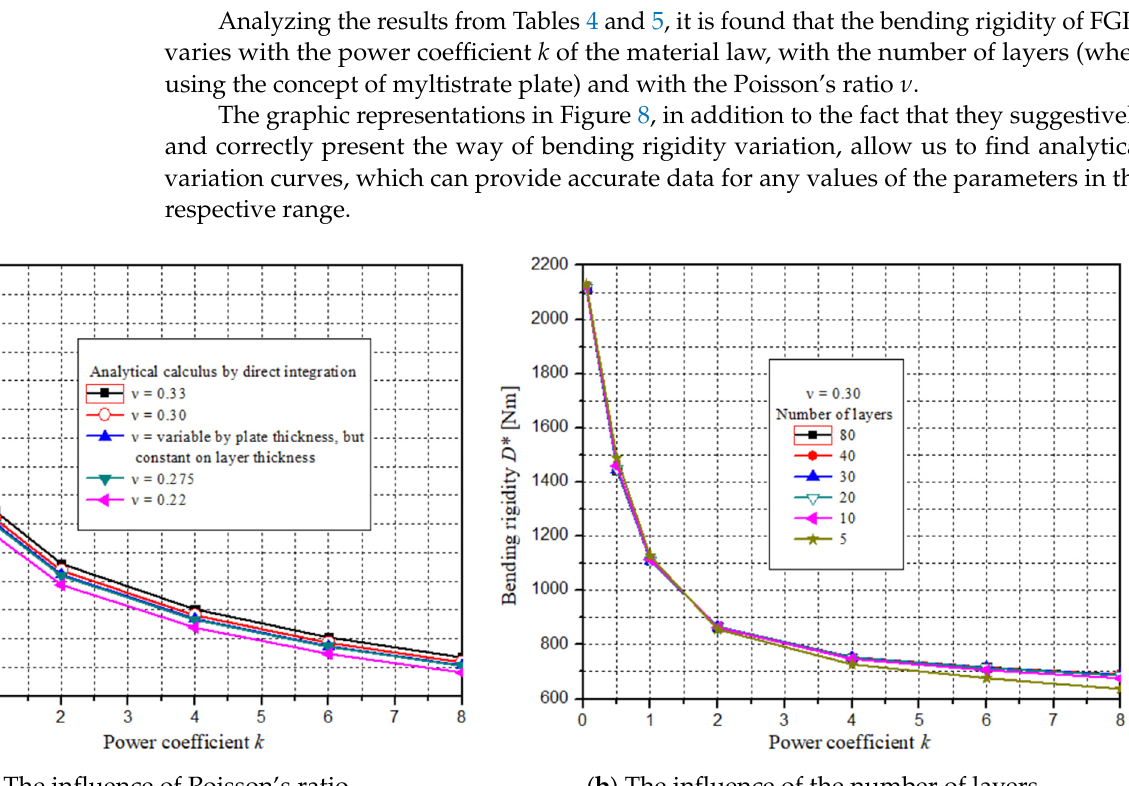
Figure 8. Bending rigidity versus power coefficient k, for different Poisson’s ratio ( a ) and layers ( b ).